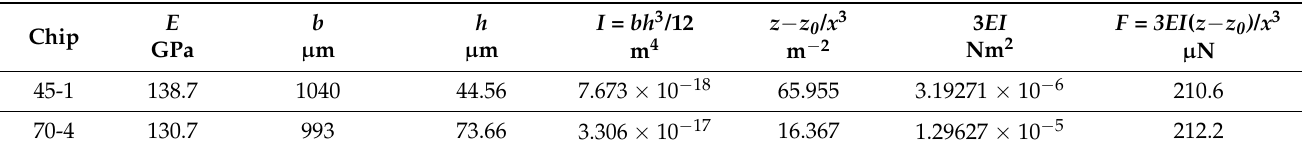
Table 8. Determination of the stylus force by evaluating the whole profile.